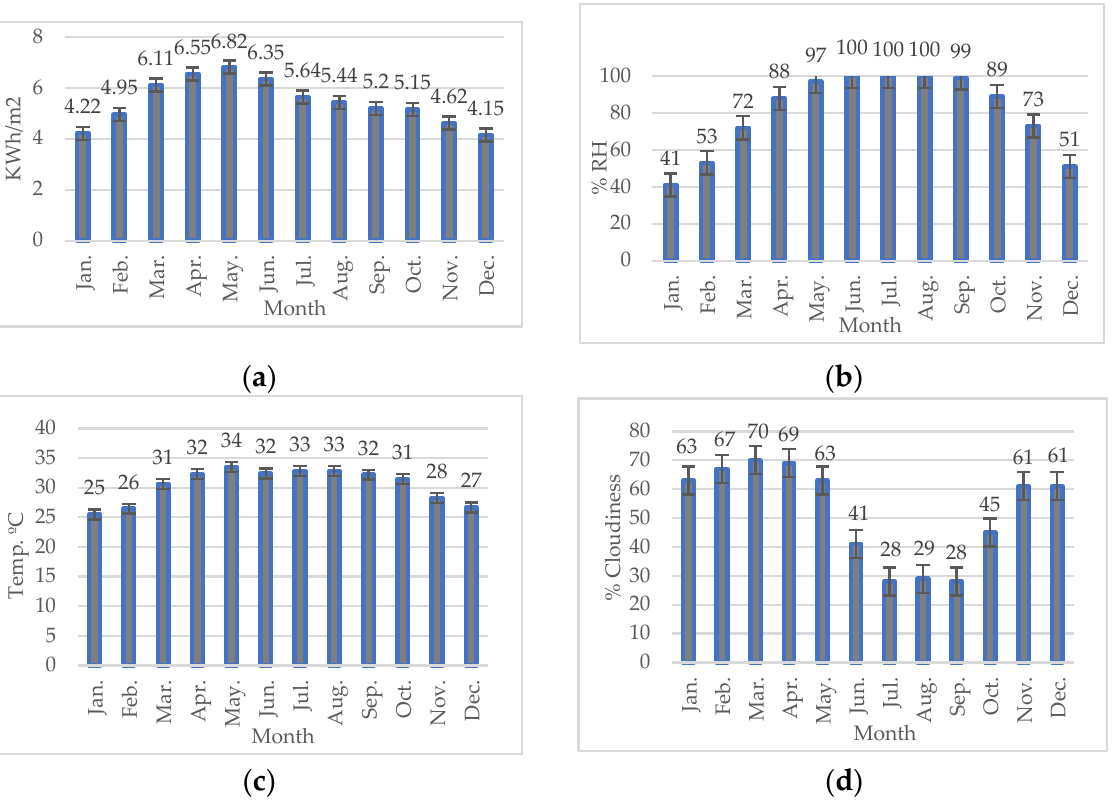
Figure 1. Average annual climatic behavior in Tecolutla, Mexico. ( a ) Solar radiation, ( b ) Relative humidity, ( c ) Ambient temperature, and ( d ) Cloudiness. The figures show the monthly average behavior of each parameter and indicate their respective values per month. (The figure includes standard error bars).